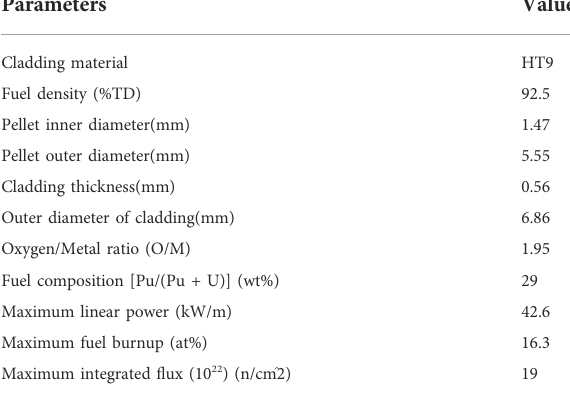
TABLE1Speci fi cationsofpelletinACO-3fuelrod(Bridgesetal.,1993; Karahan and Buongiorno,